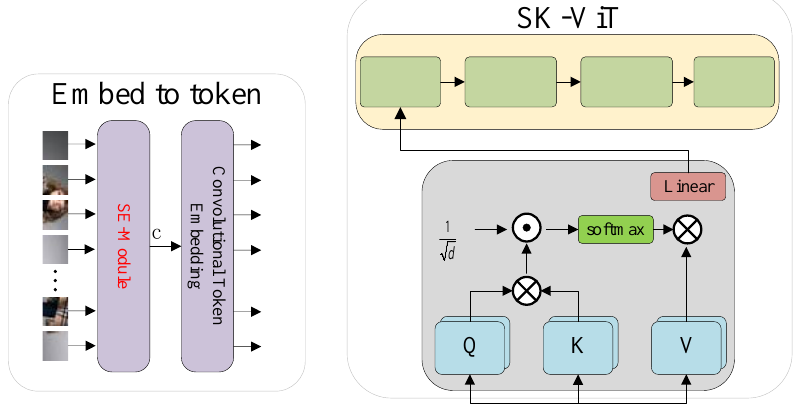
Figure 2. Embed to Token and SK-ViT modules.